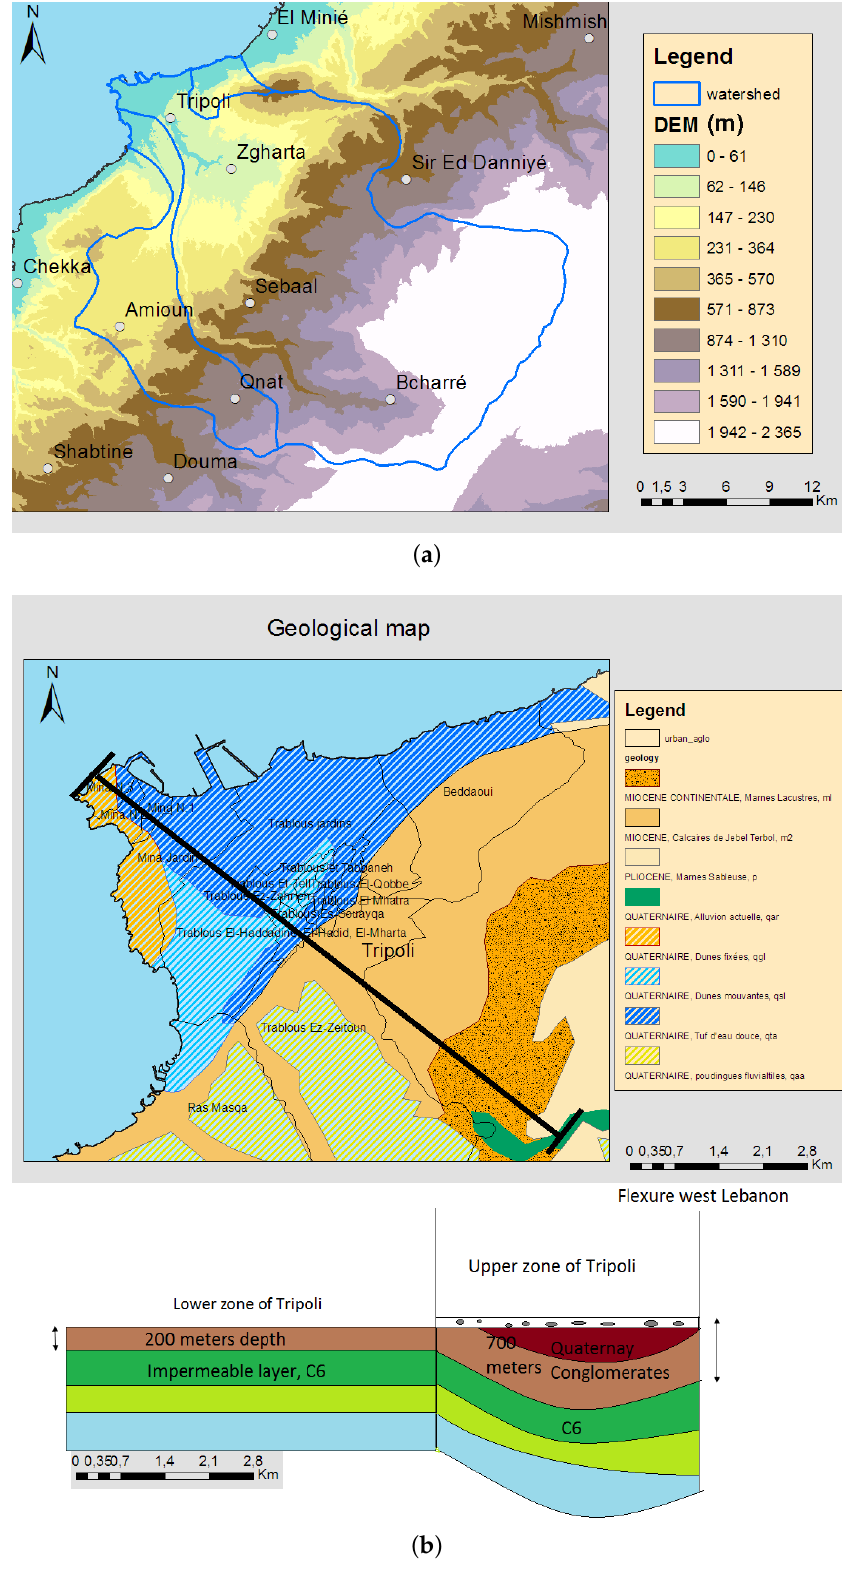
Figure 2. Elevation and geological maps of area of interest; ( a ) Elevation Map of Tripoli watershed; ( b ) Geological map and stratigraphy of Tripoli